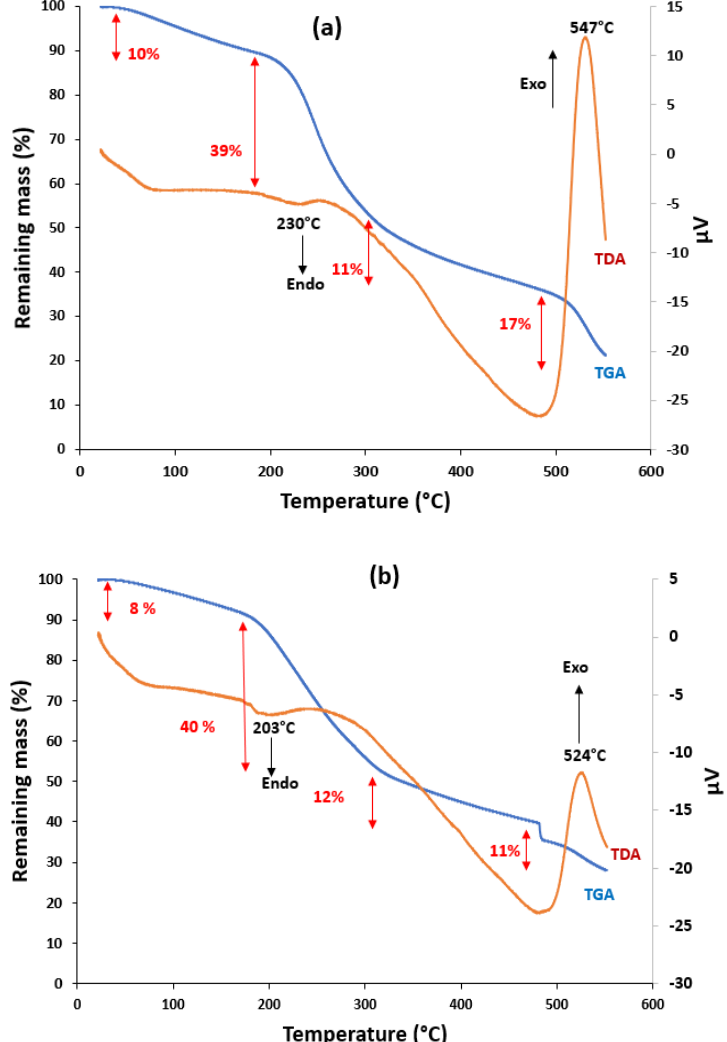
Figure 5. Thermal gravimetric analysis of: ( a ) pectin beads and ( b ) pectin − [Sb(TPP)Cl 2 ] composite beads